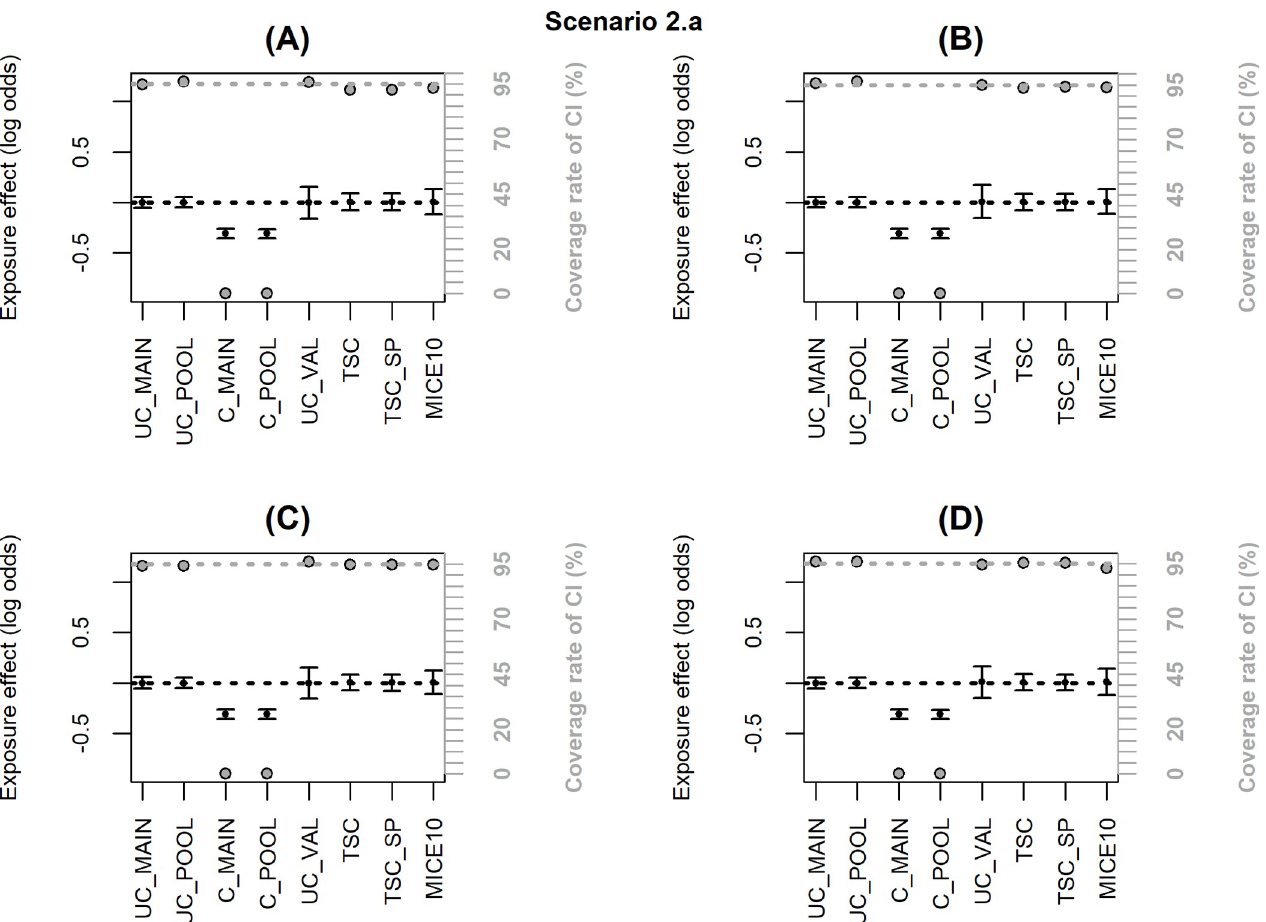
Fig 3. Simulation results when the inclusion probability in the external validation sample (notated P) depends only on X , Y , C or C � Y (scenario 2.a); coverage rate of 95% confidence interval (grey dot with black margin) and mean estimated log-odds ratio for the exposure effect (black dot) ± empirical standard error: (A) logit(P) = − 2.7+log(4) X , (B) logit(P) = − 2.7+log(4) Y , (C) logit(P) = − 2.7+log(4) C grey dotted line corresponds to the nominal value of the coverage rate of the 95% confidence interval. The black dotted line is the true value of β (0).